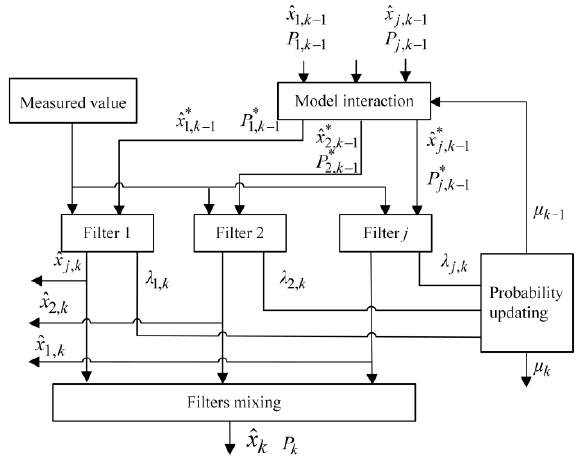
Figure 4. IMM algorithm framework.